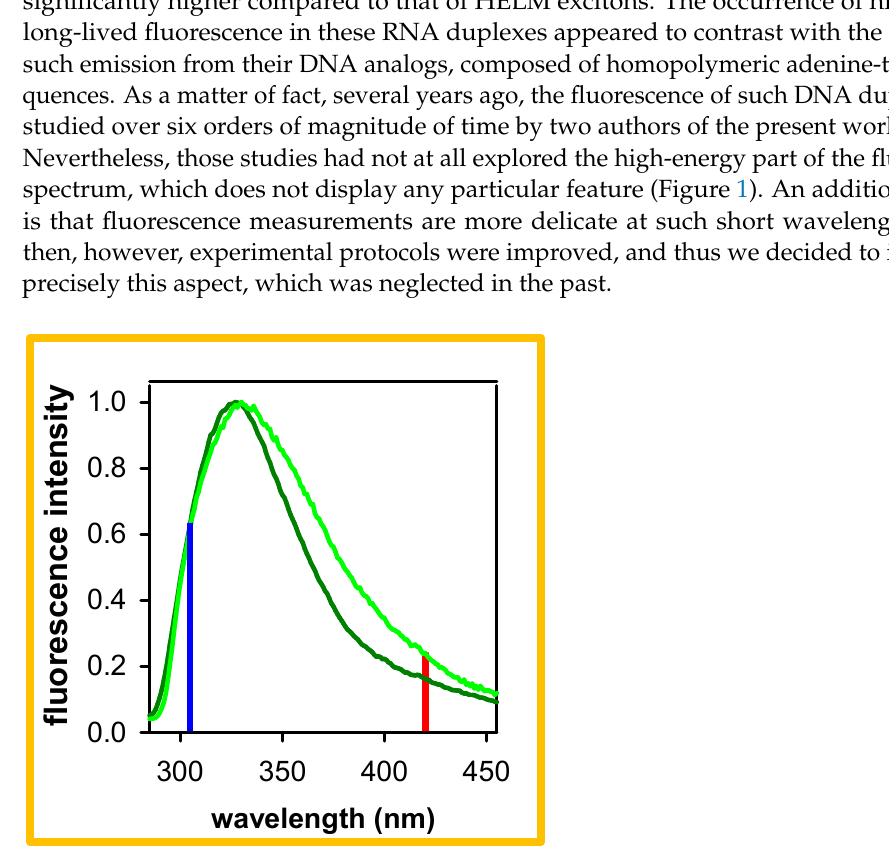
Figure 1. Steady-state fluorescence spectra recorded for pA • pT (dark green) and A 20 • T 20 (light green) following excitation at 267 nm [30]; their intensity was normalized at the maximum; vertical blue and red lines indicate, respectively, 305 and 420 nm, where fluorescence decays and fluorescence anisotropy traces are shown herein.